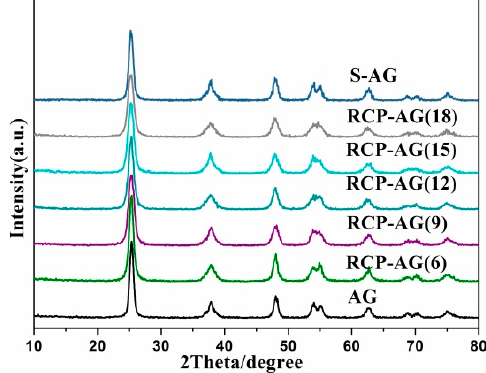
Figure 1. XRD patterns of the samples.